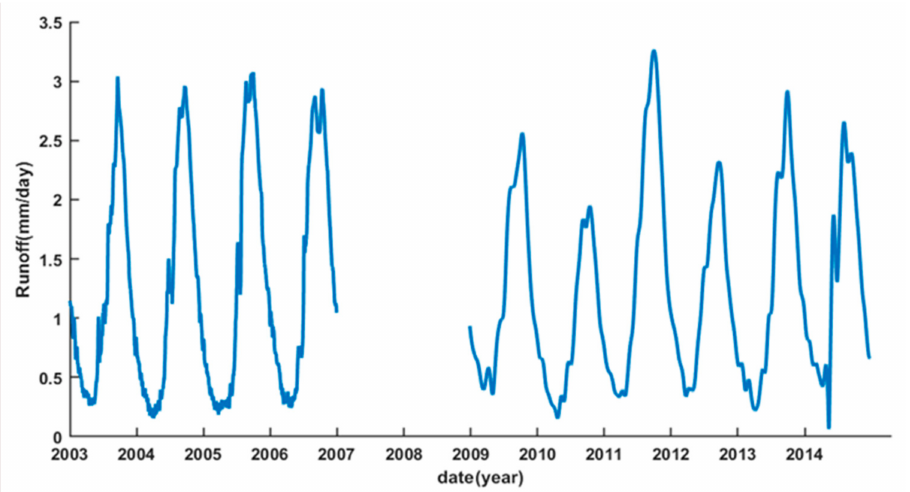
Figure 2. Daily runoff time series of TC-CD stations within the river delta during 2003–2006 and